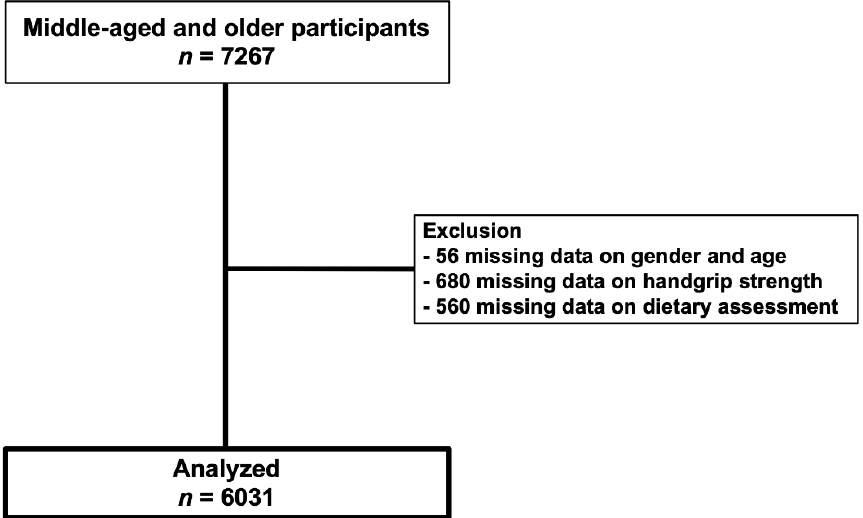
Figure 1. Flowchart depicting the selection of